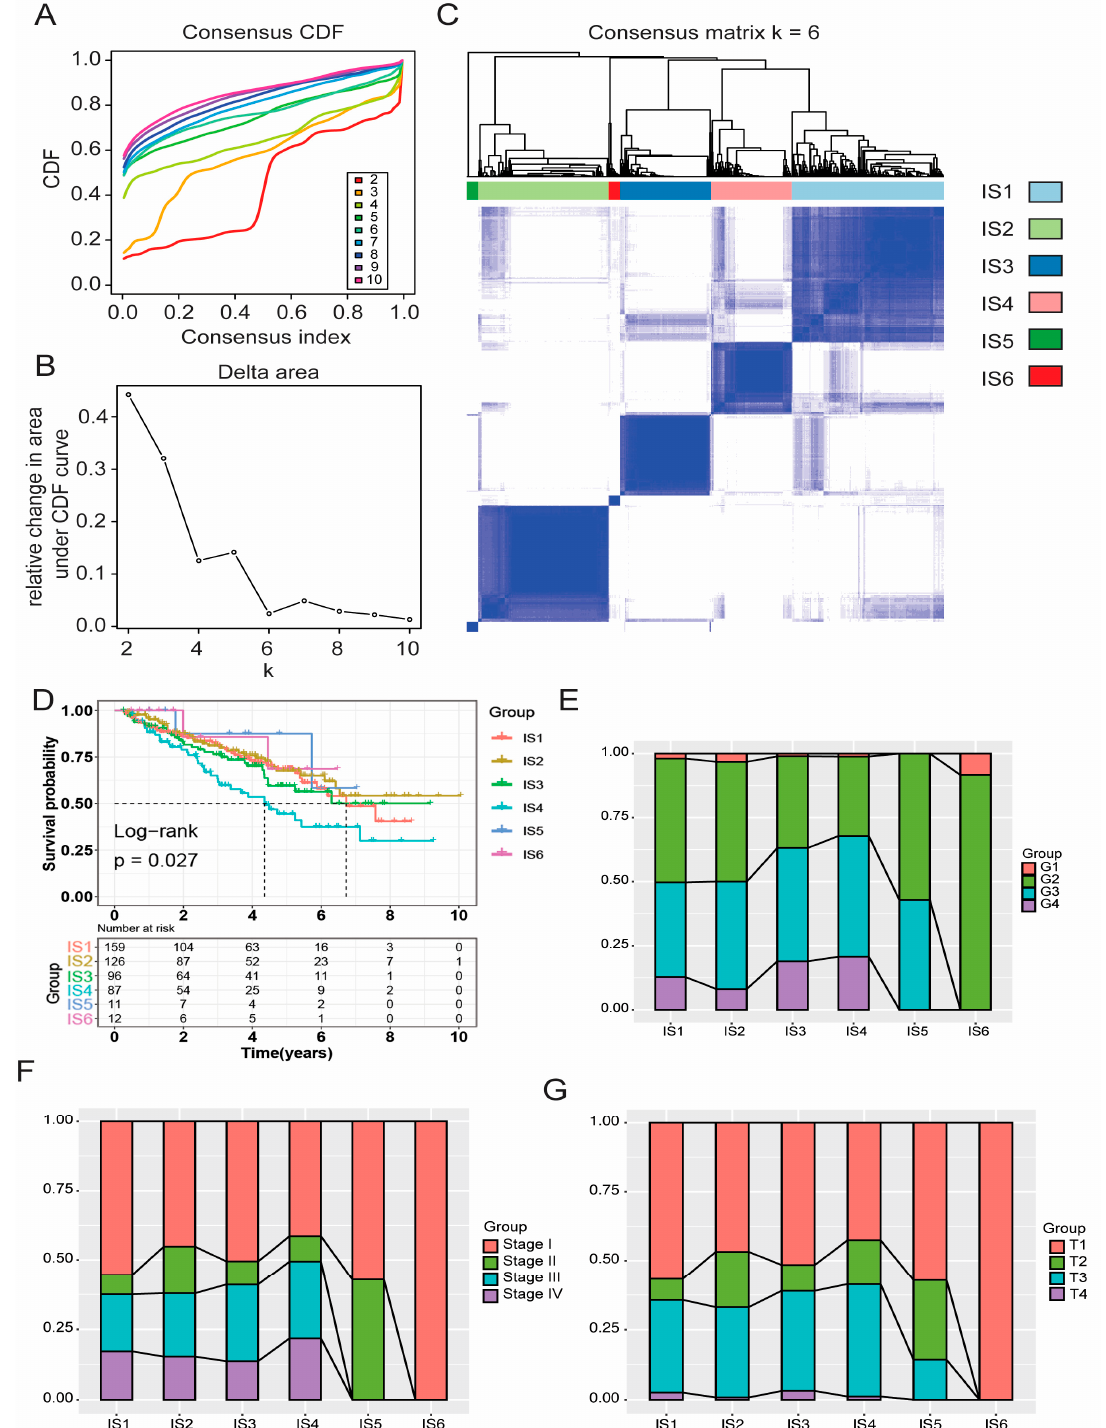
Figure 5. Identification of immune subtypes of KIRC. Cumulative distribution function curve ( A ) and triangular area ( B ) of immune-related genes in the TCGA cohort. ( C ) Sample cluster heat map of immune-related genes in the TCGA cohort. ( D ) Kaplan–Meier curve showing OS of KIRC immune subtypes in the TCGA cohort. In the TCGA cohort, the proportion of IS1–6 distribution in KIRC grade ( E ), stage ( F ), and T-stage ( G ). Kidney renal clear cell carcinoma (KIRC); The Cancer Genome Atlas (TCGA); Overall survival (OS); Immune subtype (IS).